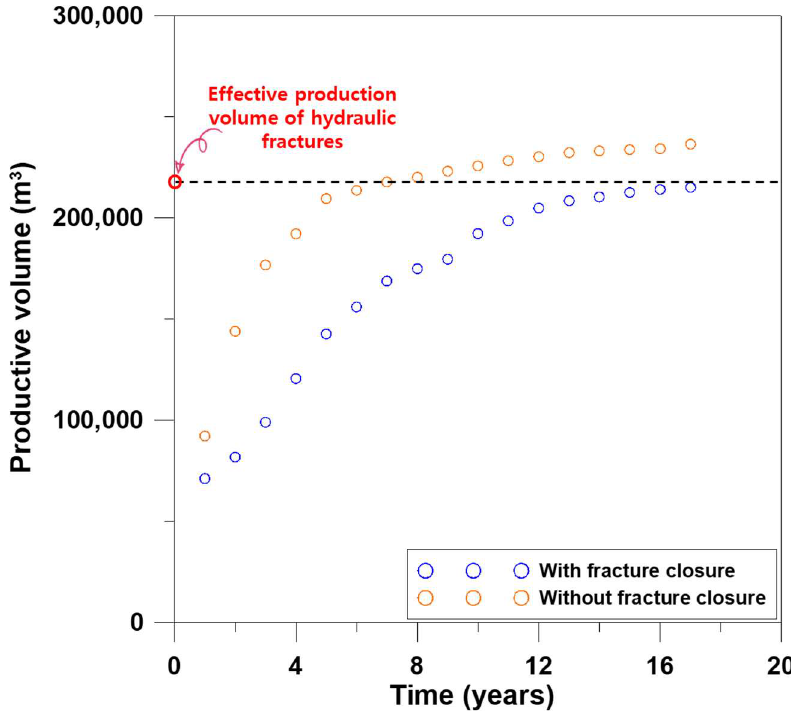
Figure 20. Simulated change in productive volume of hydraulic fractures over time, with and without fracture closure relationship.